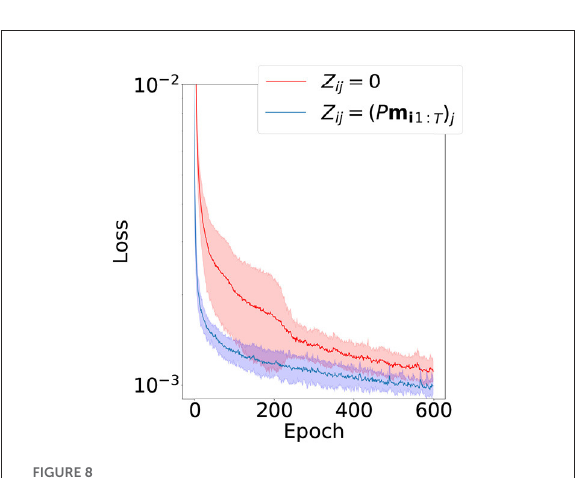
FIGURE8 Mean and standard deviation of the convergence of the loss function in the second part of inter-primitive generalization experiment. The dimension of latent vectors is 20.